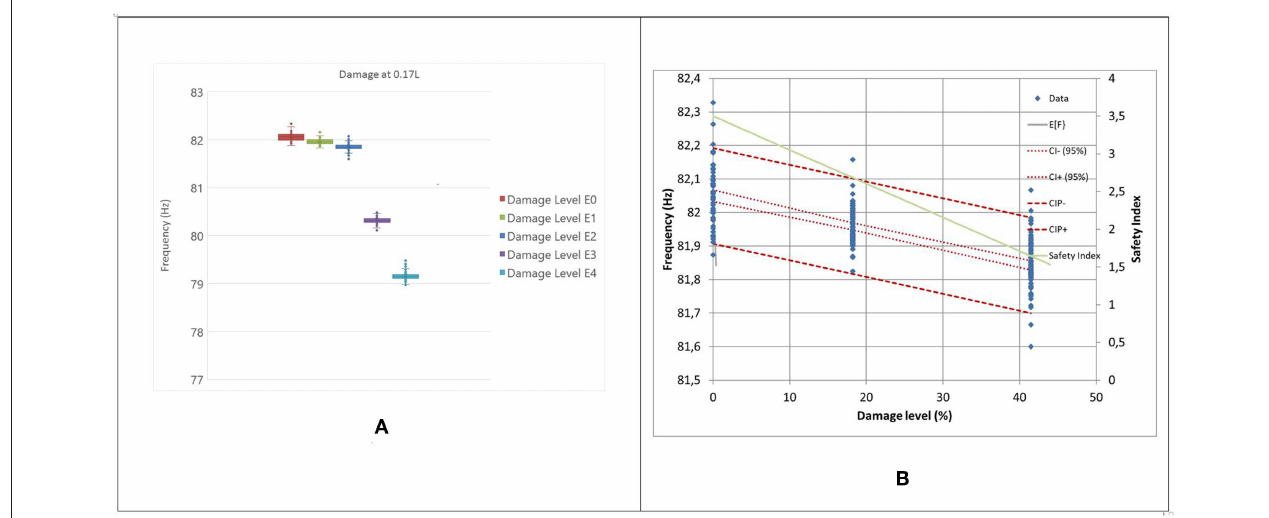
FIGURE 4 | Damage located at 0.17L. (A) Whisker plot of the frequency of the first mode of vibration at 5 damage levels, (B) Linear regression of frequency as a function of damage level (Damage levels E 0 , E 1 , and E 2 ).